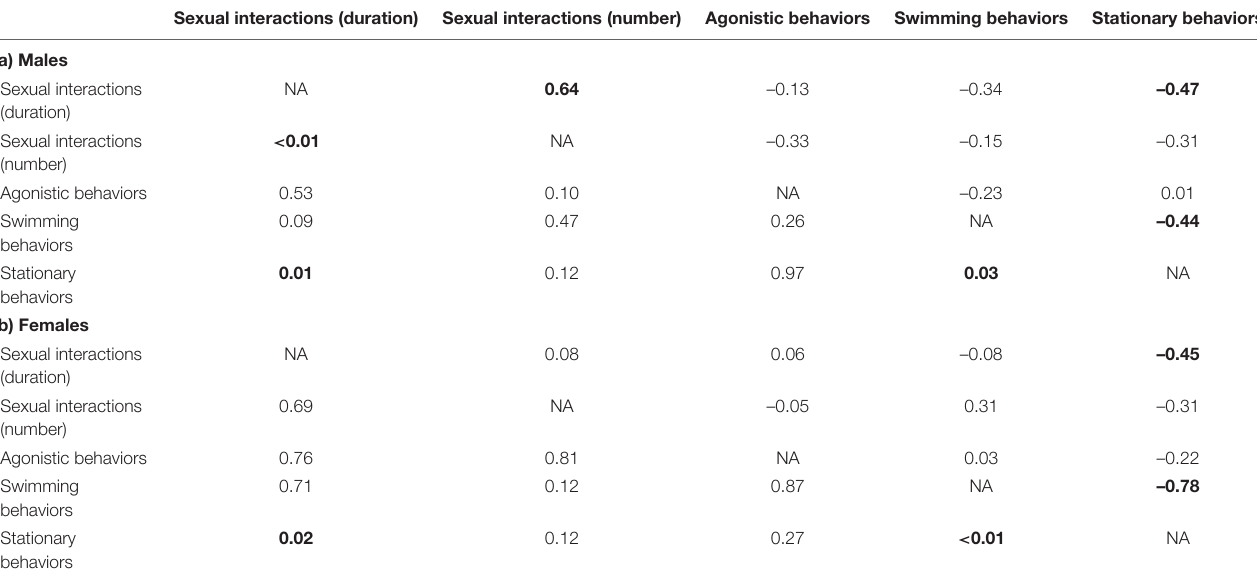
TABLE 2 | Spearman correlation coefficients (above the diagonal) and respective p values (below the diagonal) are shown for the total duration and number of sexual interactions, the total number of agonistic behaviors, and the total duration of stationary and swimming behaviors in each shoal in (a) males and (b) females. Sexual interactions (duration) Sexual interactions (number) Agonistic behaviors Swimming behaviors Stationary behaviors